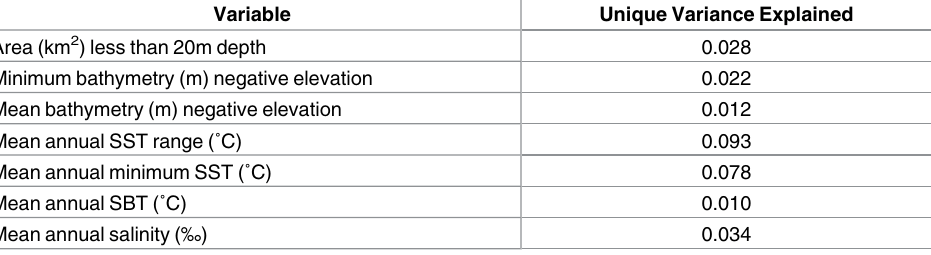
Table 2. Factors retained and their weightings in species distribution model to determine potential range of lionfish if introduced to the west